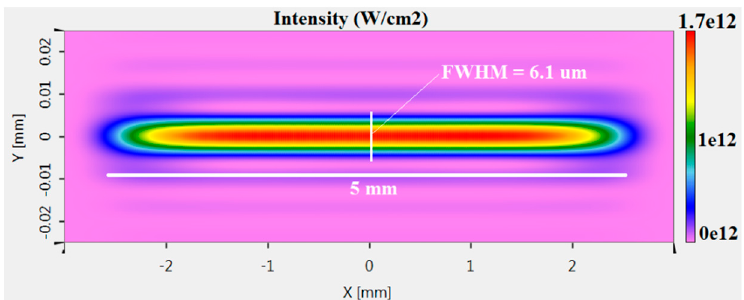
Figure 2. Simulated high-aspect ratio focal distribution (transverse plane) obtained by the combination of a 200-mm plano-convex and a 100-mm cylindrical lens.